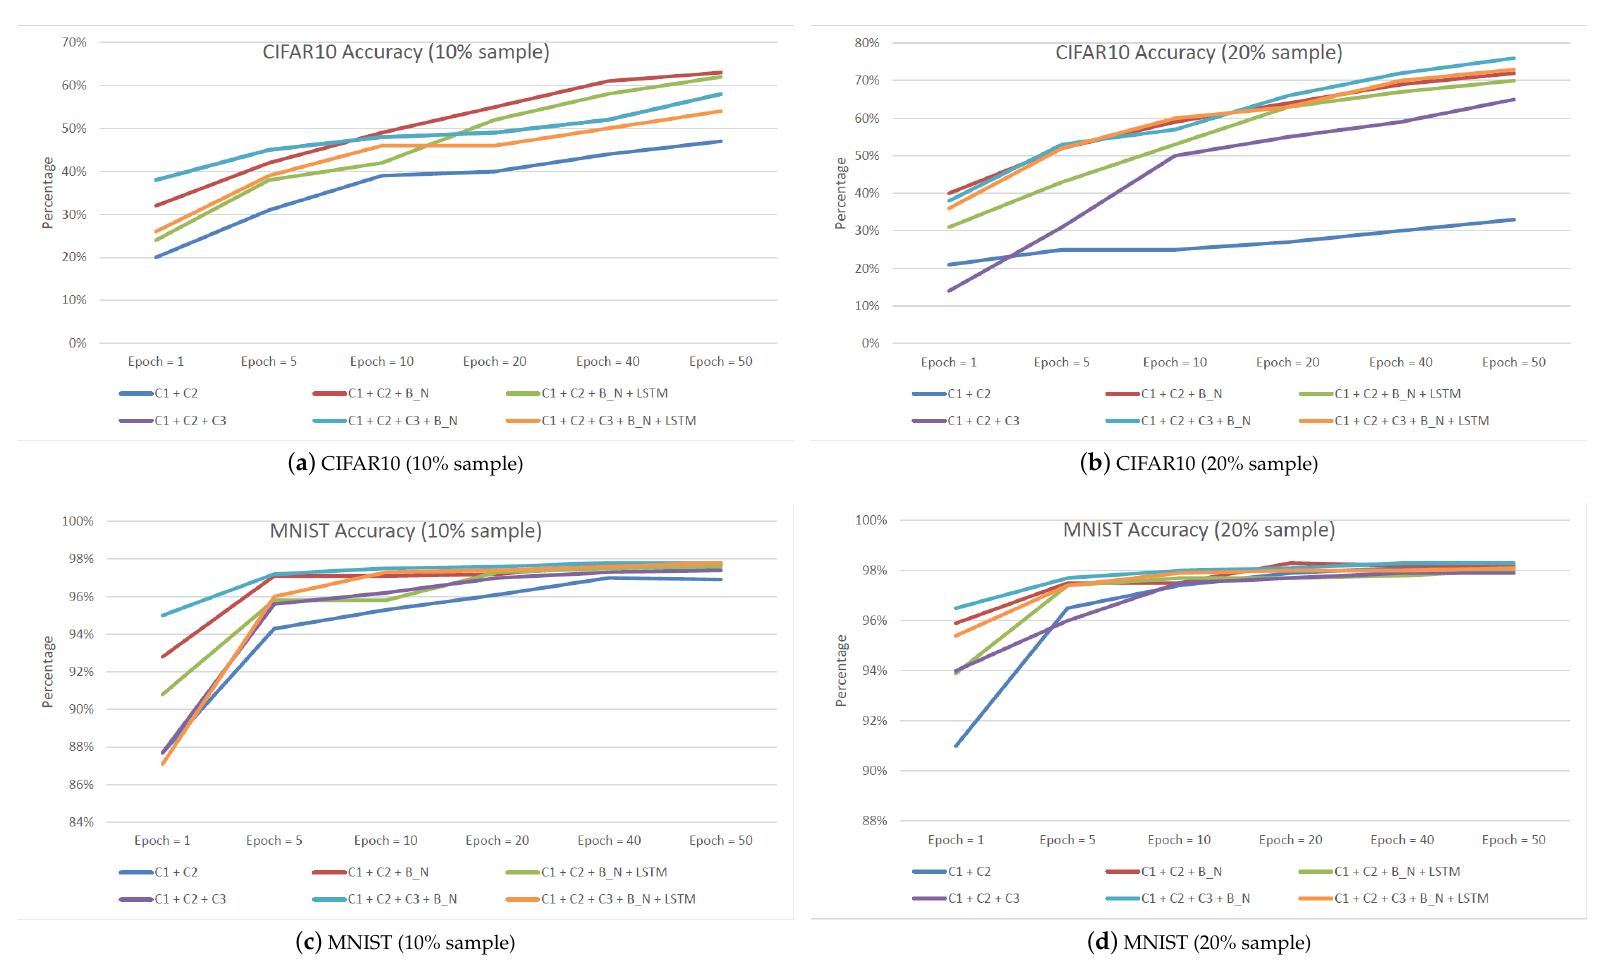
Figure 2. Accuracy (percentage) for different numbers of epochs for CIFAR10 and